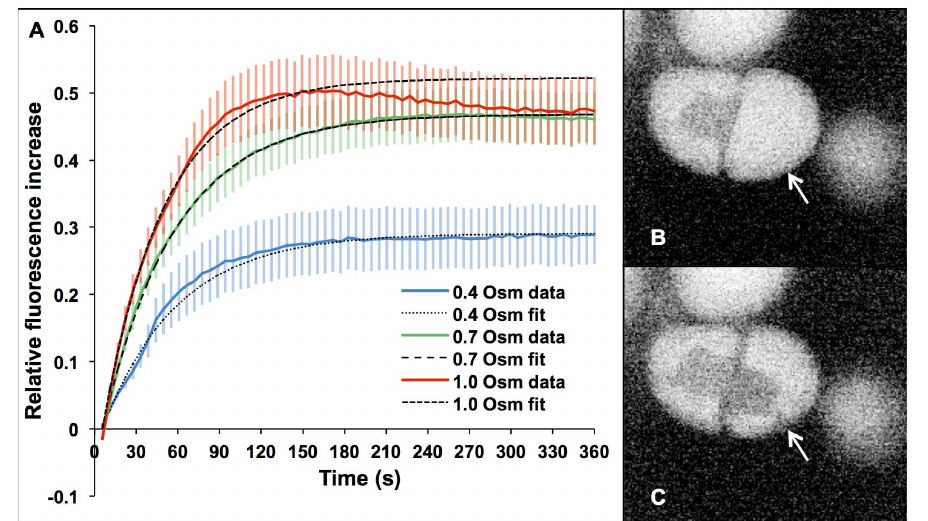
Figure 5. Uptake of calcein during photoporation in hypertonic medium. Solid lines in A show the mean increase in intracellular fluorescence relative to background for n=20 cells with error bars representing 0.5 S.E.M. for clarity. Each curve shows a sharp increase in fluorescence in the first few minutes after photoporation, which plateaus after around 3 minutes. The higher molarity solutions show a quicker increase in calcein uptake and reach a higher level of maximum fluorescence than the lower molarity solutions. Dashed lines denote fitted saturation curves. B and C show a cell (arrowed), in negative contrast for clarity, before and 60 seconds after photoporation in 0.4 Osm/L medium containing calcein. The nucleus, indistinguishable from the rest of the unporated cell in B, becomes filled with calcein along with a cytosolic strand (just visible at arrow tip) but none enters the large vacuole surrounding it.